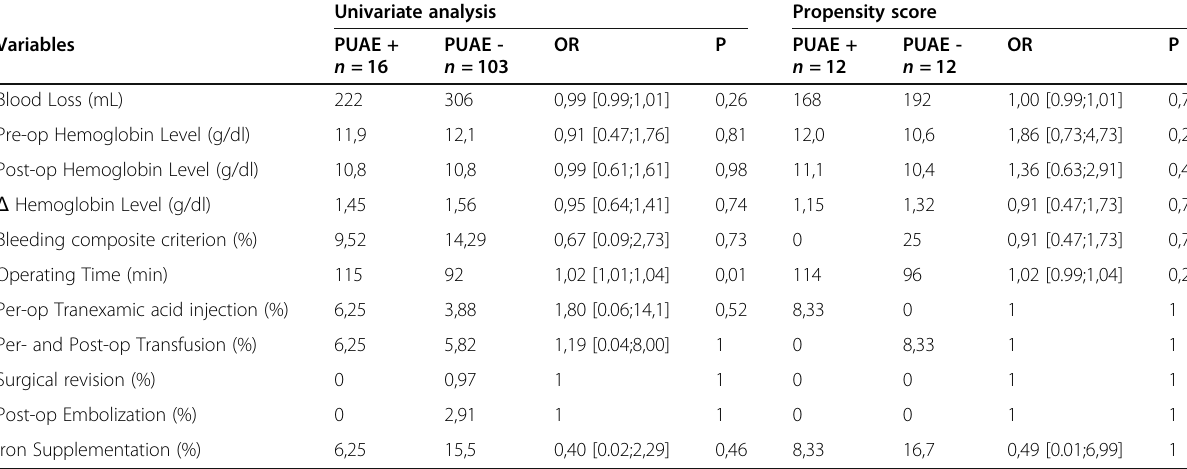
Table 2 Intervention Data Univariate analysis Propensity